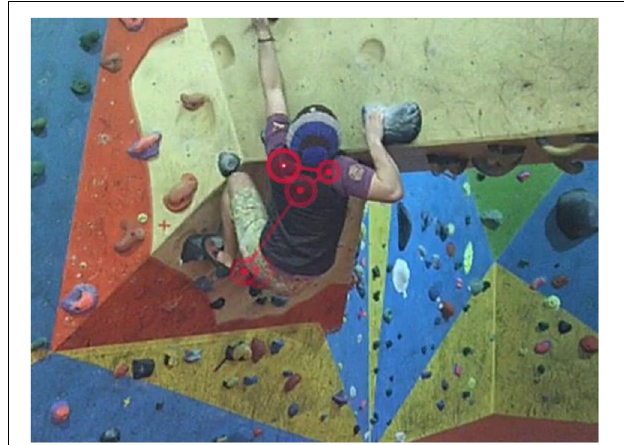
FIGURE 1 | Example of how the gaze data were presented to coaches to cue retrospective think-aloud: visual gaze data super-imposed as 2-s scan path [a connected string of fixations (circles) and saccades (connecting lines)] to cue verbal responses (i.e., why coaches focus on specific fixation